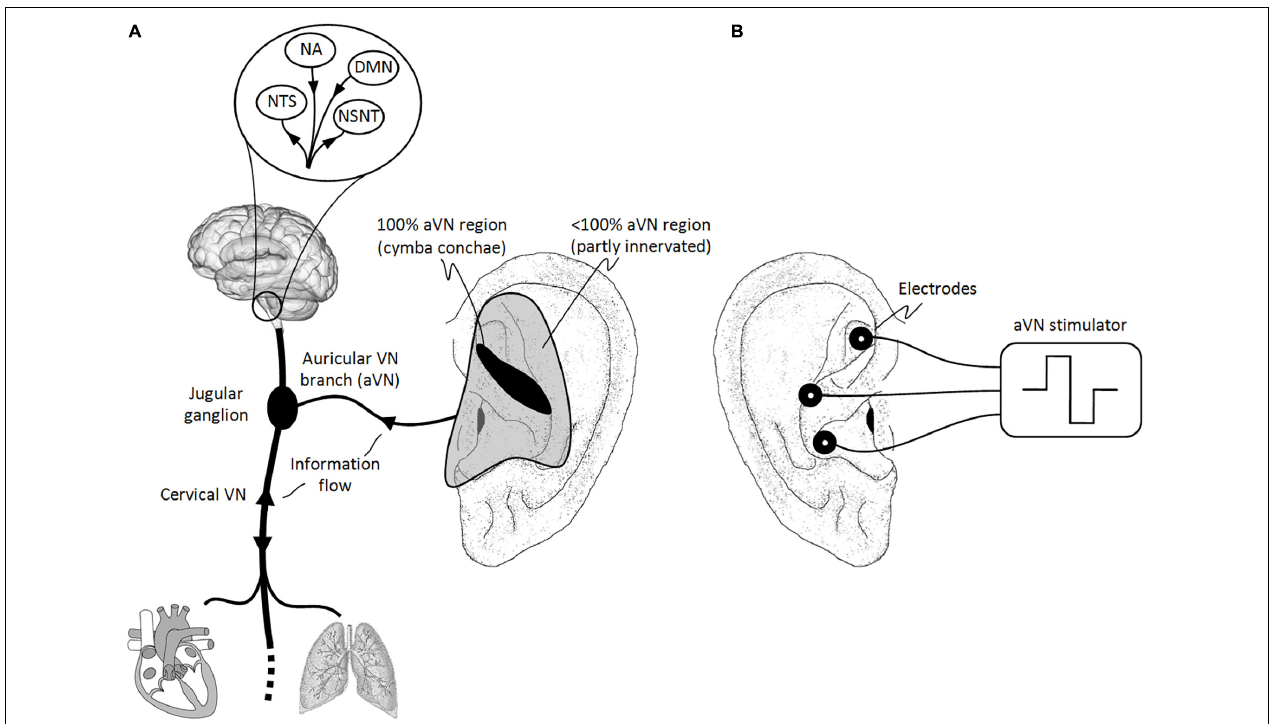
FIGURE 1 | Natural sensory innervation of the auricle versus its artificial stimulation. (A) The vagus nerve (VN) connects the brain with most of the organs within the thorax and abdomen. Afferent auricular branches (aVN) leave the cervical VN at the level of the jugular ganglion just outside the cranium and innervate the rather central regions of the pinna of the outer ear (Peuker and Filler, 2002). (B) Electric stimulation of aVN endings with needle electrodes located within these central regions. NTS, nucleus of the solitary tract; NSNT, nucleus spinalis of the trigeminal nerve; NA, nucleus ambiguous; DMN, dorsal motor nucleus. This figure and figure caption was originally published in the sister manuscript to this review (Kaniusas et al., 2019), which was published in Frontiers of Neuroscience under the creative commons attribution license CC BY